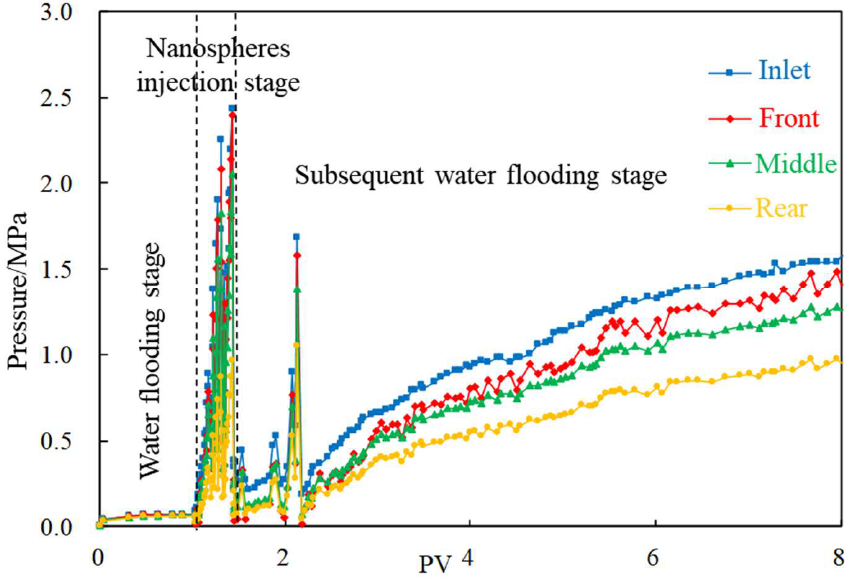
Figure 2. Typical displacement pressure change curve (100 nm nanospheres).